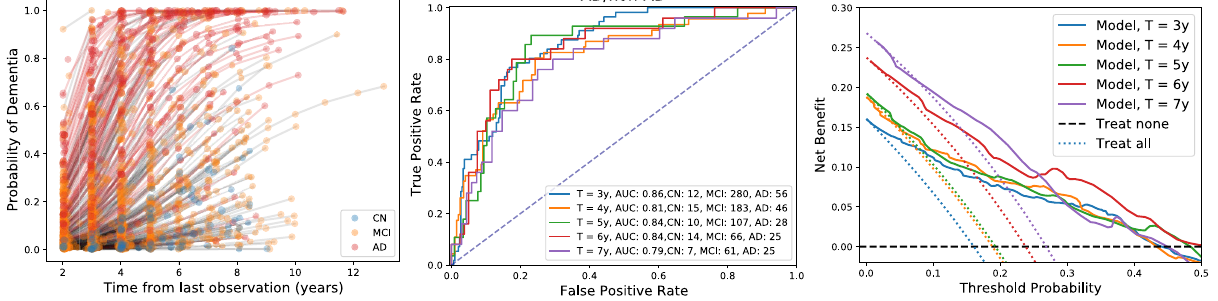
Figure 5. Prediction of conversion from MCI to AD as a function of time from baseline in the cross- validation experiment. Left: Probability assigned to the AD label as a function of time. Dots show the diagnosis assessments (the colour denotes the diagnosis), and lines connect assessments of the same subject. Red lines are used for subjects with an AD diagnosis at any point during the follow-up (converters), and grey lines are used for the rest (non-converters). The blue dots correspond to subjects who reversed their diagnosis to CN after being MCI during the first two years. Centre: Accuracy (ROC curves) of the conversion prediction (AD/ non-AD classification) at specific times after baseline. There is at most one diagnosis assessment per subject each year, and the number of subjects is reduced for longer follow-ups (see the legend). Right: Decision curves. The AD prevalence equals the intersection of the “Treat all” strategy with the “Treat none” strategy. The model is useful only for probability thresholds for which the Net Benefit is greater than for the “Treat all” and “Treat none” strategies. The probability threshold depends on the risks and benefits of the therapy under